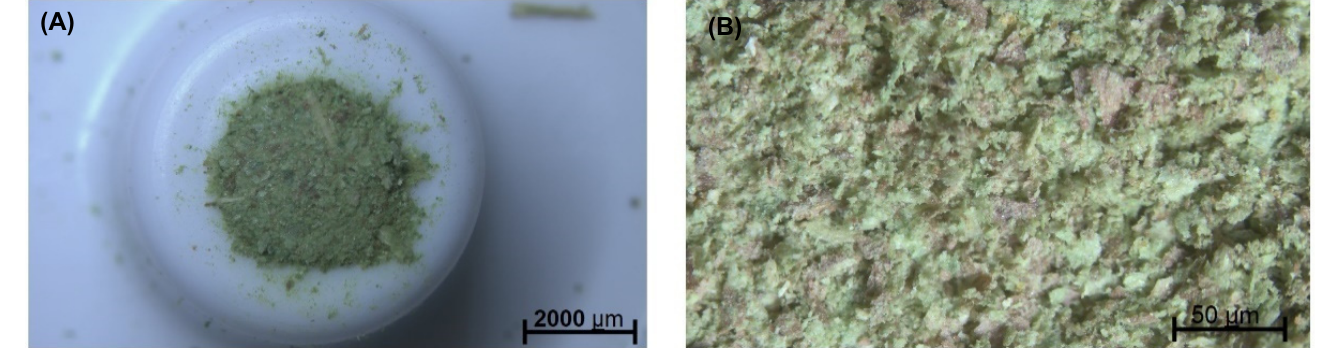
Figure 3. Sample preparation into stubs before XRF analysis ( A ). Representative image at the stereomicroscope of powder texture after milling process ( B ).